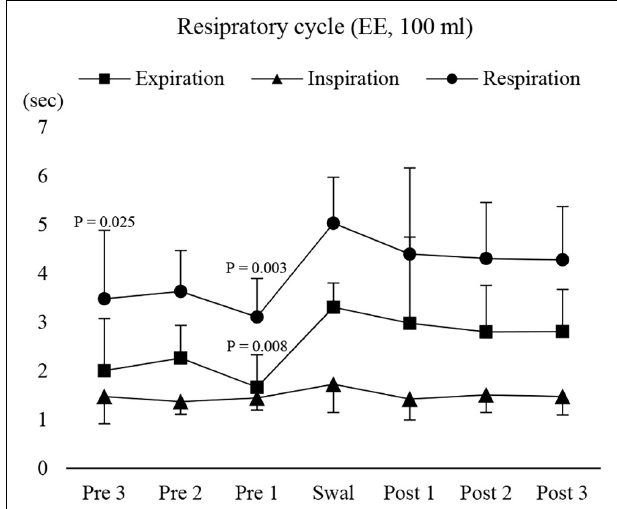
FIGURE 7 | Changes in respiratory, inspiratory, and expiratory time before, during, and after 100-ml water swallowing (expiration–swallow–expiration type, EE type). Swallowing apnoea time was excluded. Expiratory time immediately before (Pre 1) swallowing was significantly shorter than that during swallowing (Swal) (one-way repeated measures ANOVA followed by Tukey test, P = 0.005, df = 5, F = 3.887). This was also the case for the respiratory time, which was significantly shorter before (Pre 1 and 3) swallowing compared with that during swallowing (one-way repeated measures ANOVA followed by Tukey test, P = 0.005, df = 5, F = 4.39). The results of the post hoc test are shown in the figure. Post, after